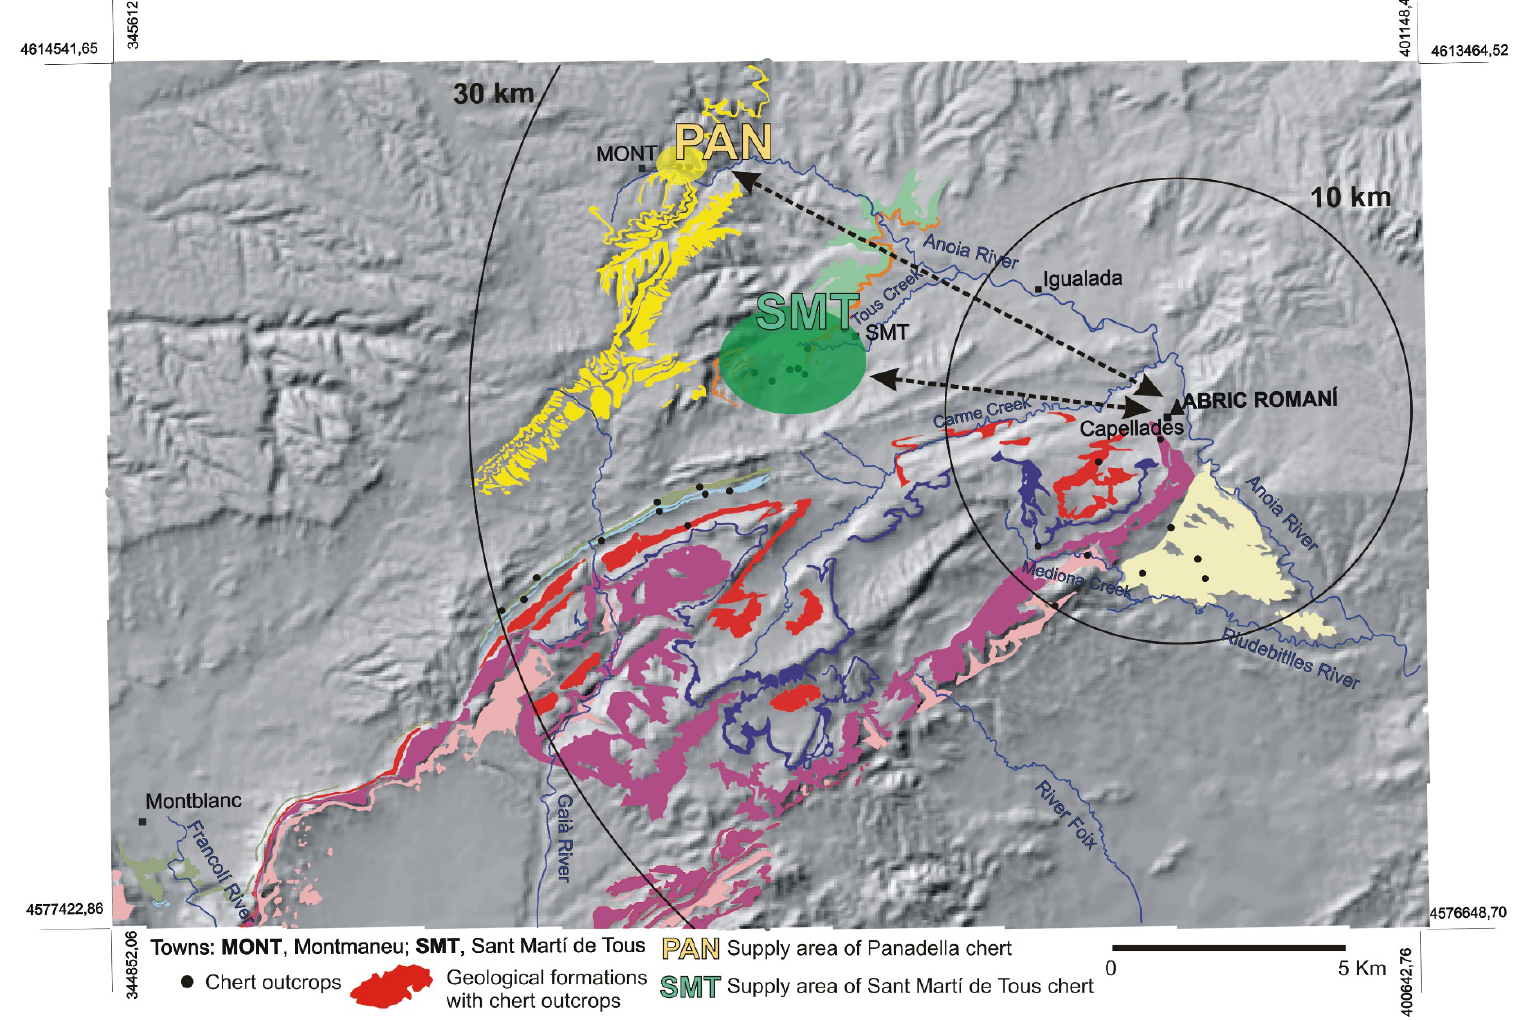
Figure 2. Location of the site (black triangle on the right) and of geological formations exploited by Neanderthals. Green (SMT) and yellow ovals (PAN) show the supply areas of chert formations analysed in the paper. Black dots show the chert outcrops analysed with macro- and microscopic archaeo-petrographic